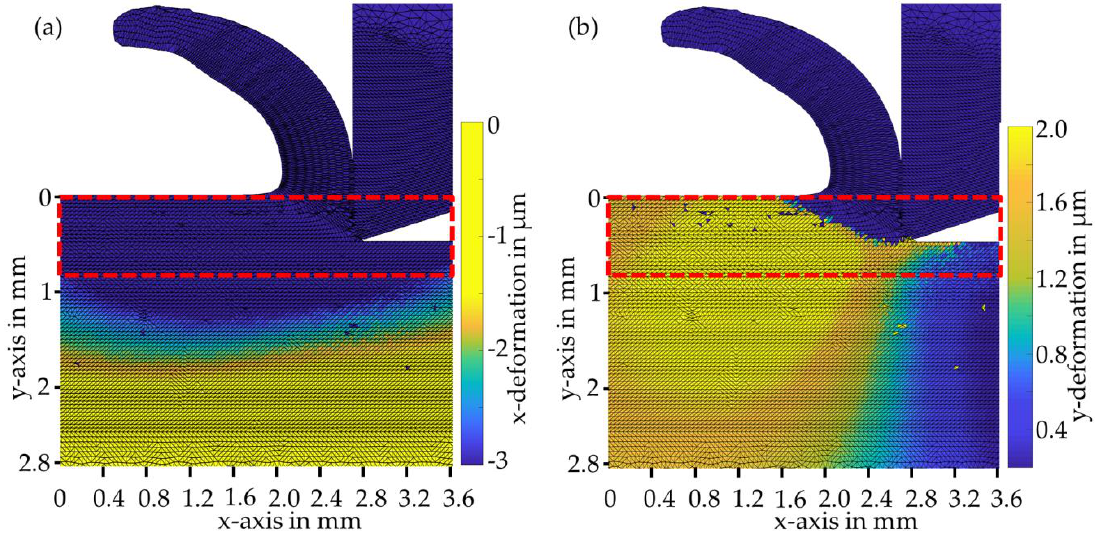
Figure 9. Simulated loads of single-tooth milling process. ( a ) Deformation in the x-direction and ( b ) deformation in the y-direction.